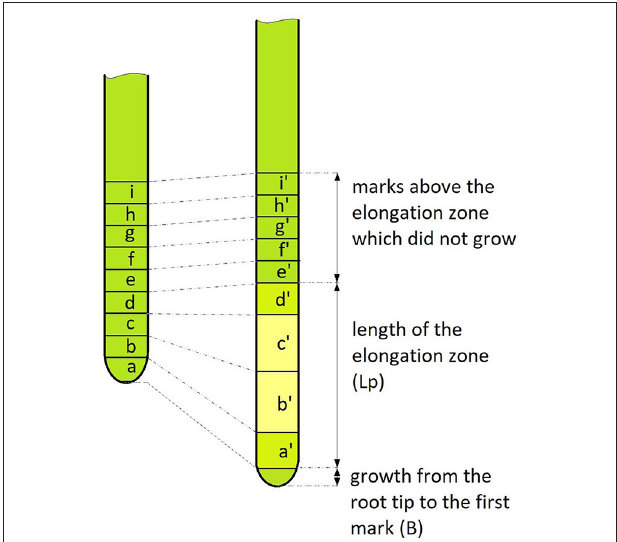
FIGURE 1 | Schematic picture of the applied growth rate measurement model. On the left is the root before the start of the measurement, on the right—after. A number of uniform marks were applied to the root (nine in this example). The marked zone after the measurement period (T, which mainly lasted 5 or 10 days) shows that some of the marks grew (marks a, b, c, d), forming the elongation zone Lp. Also, the root grew from the last mark (B), which was not observed in all dimensions. The ratio of the length of the growth zone after and before the start of observation gave the growth coefficient S = (a’ + b’ + c’ + d’)/(a + b + c + d). Thus, formula (1) by which we calculated the growth rate is equivalent to the net increase [(a’ + b’ + c’ + d’) – (a + b + c + d) + B] divided by the measurement interval